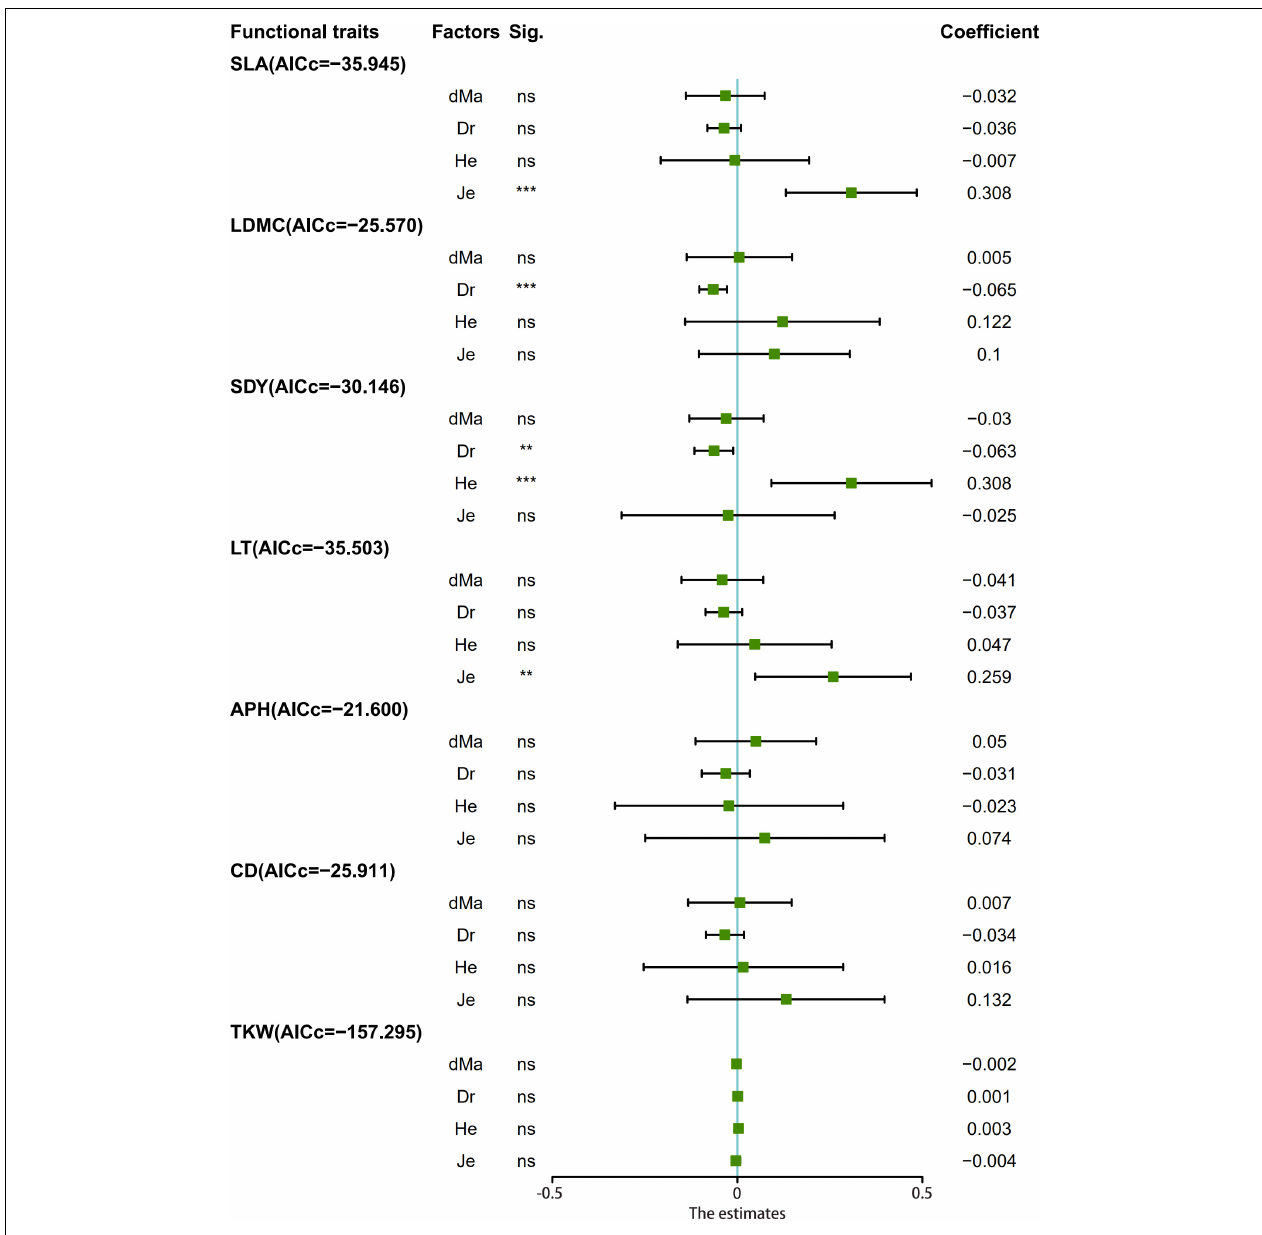
FIGURE 7 | Generalized linear mixed model (GLMM) model coefficient estimates and 95% confidence intervals showing the influence of the alpha diversity of communities no the shrub functional traits on the landslides. SLA, specific leaf area; LDMC, leaf dry matter content; SDY, stem density; LT, leaf thickness; APH, average plant height; CD, crown diameter; TKW, thousand kernel weight; **, significant at the 0.05 level; ***, significant at the 0.01